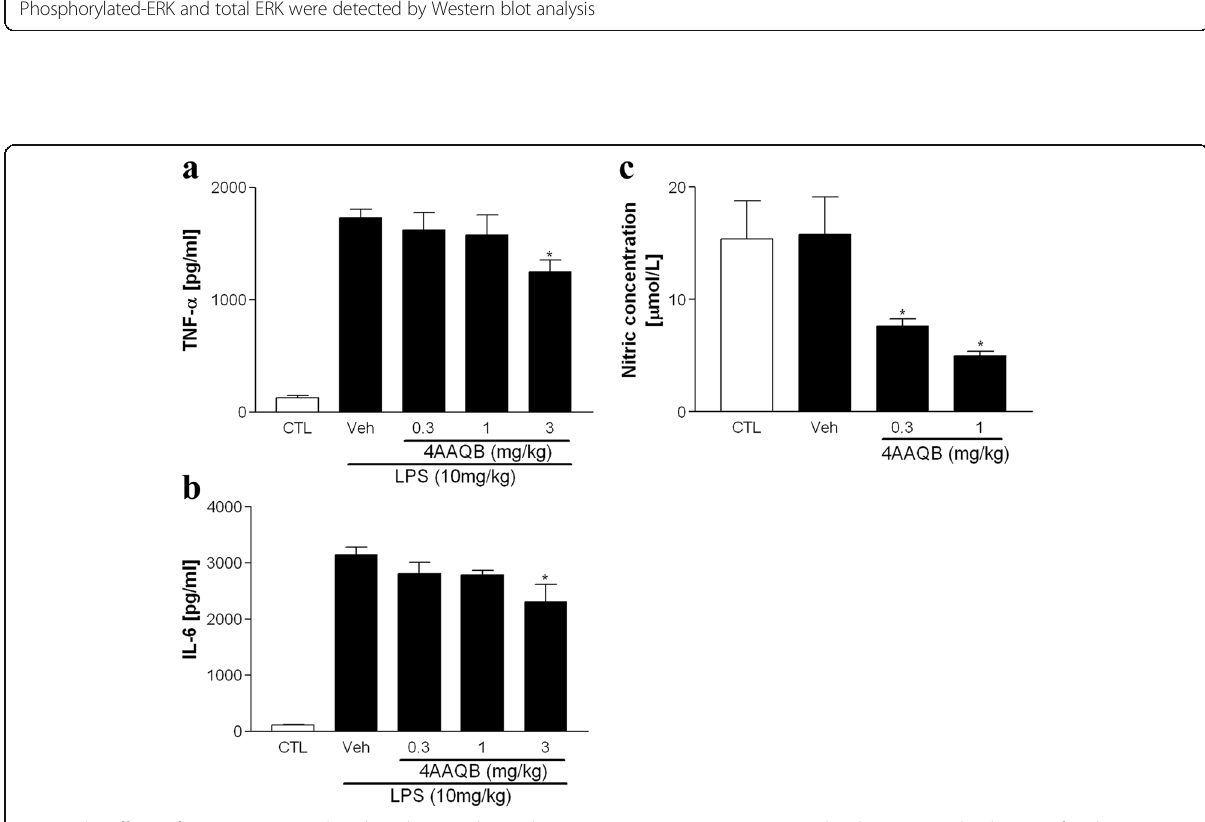
Fig. 6 The effects of 4AAQB on LPS-induced cytokines and NO release. ICR mice (25 – 30 g) were treated with 4AAQB and induction of endotoxemia with LPS (20 mg/kg) after 30 min. After 24 h, mice were euthanized collect blood by cardiac puncture. The serum was obtained and the cytokines TNF α /IL-6 ( a and b ) and NO ( c ) were measured. Values are presented as mean±S.E.M. ( n =10). *p <0.05 as compared with the LPS-activated